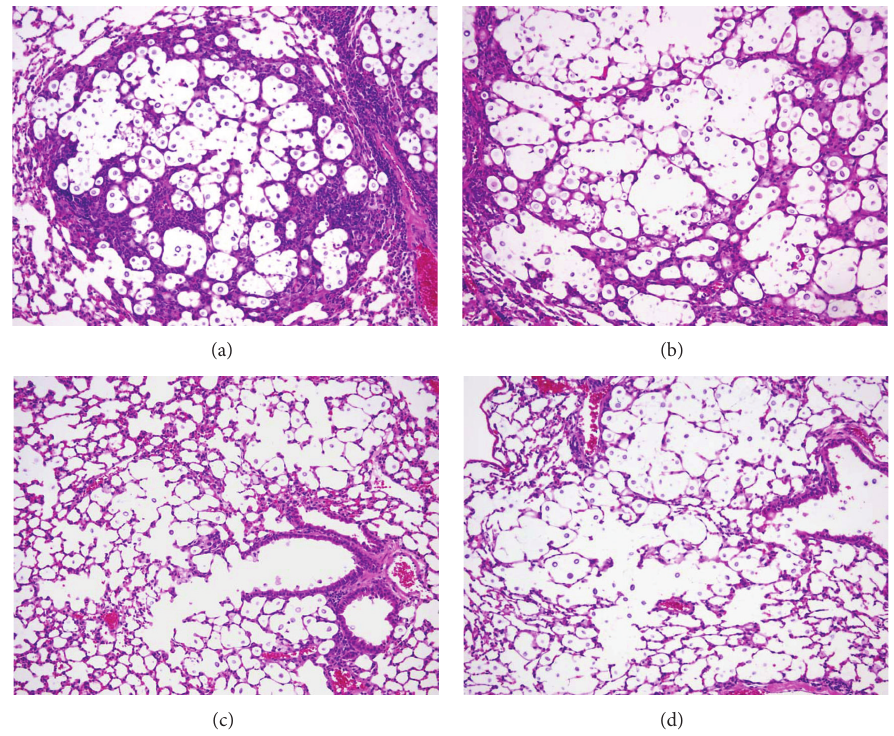
Figure 8: (a, b) On days 15 and 30 after infection, pulmonary sections of mice infected with C. gattii TIMM 4097 showed eccentric enlargement of alveoli containing prominent proliferation of yeast cells with disease progression (periodic acid Schiff (PAS) reaction, × 100, resp.). (c, d) On days 15 and 30 after infection, pulmonary sections of mice infected with C. gattii TIMM 4903 showed lesser degree of yeast cell proliferation and alveolar expansion than these with C. gattii TIMM 4097 (PAS reaction, × 100, resp.).